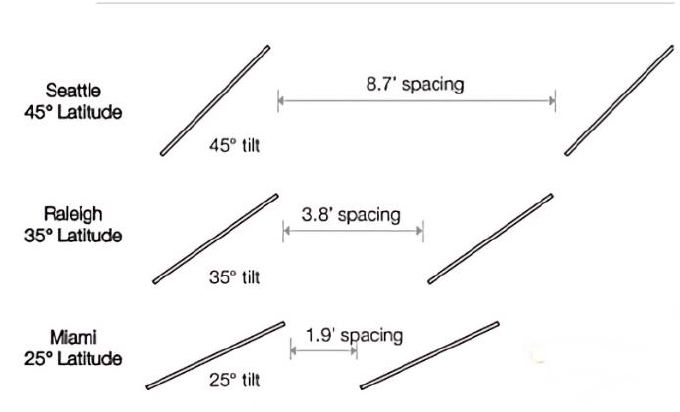
Figure 10. Latitude-tilt and spacing implications at three locations.